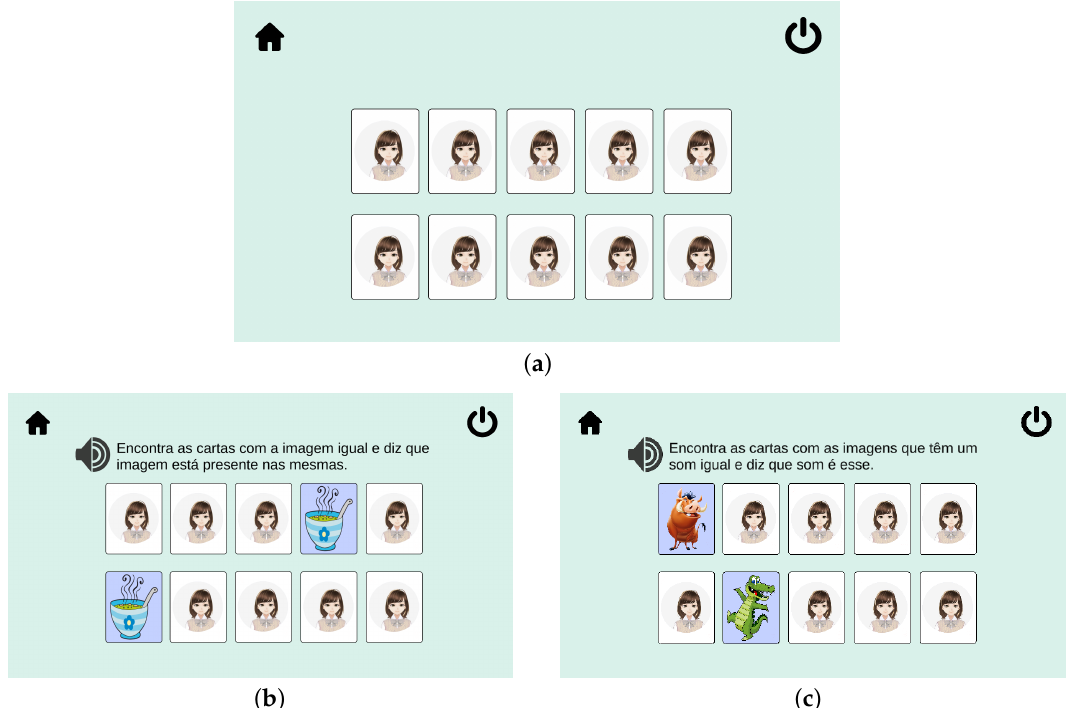
Figure 6. The BioVisualSpeech pairs game. ( a ) The game starts with all cards facing down. The girl image is a character that the child can choose. ( b ) The level for matching cards . (The instructions in the figure are: Find the cards with the same image and name that image. ) ( c ) The level for matching sounds . (The instructions in the figure are: Find the cards with the same sound and say that sound. )